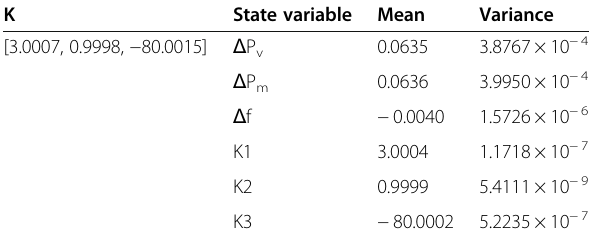
Table 3 Mean and the variance of state variables estimated corresponding to a measurement noise variance of 0.01